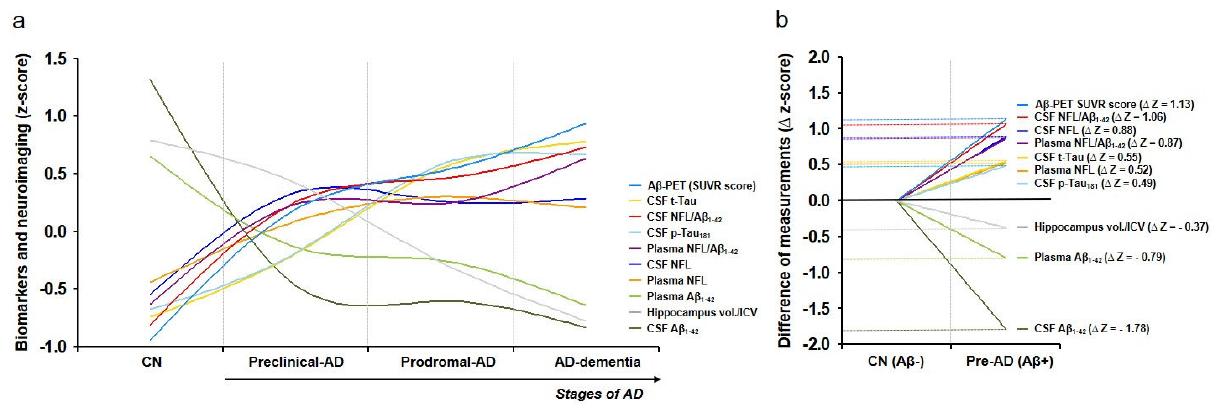
Figure 3. Dynamics of measurement. To compare biomarkers and neuroimaging data with different dynamic ranges, measurements were converted to z ‐ scores (mean values of normalized biomarker levels of each group) based on the distribution in this study cohort. The plot indicates the mean z ‐ scores for a given biomarker connected across progressively more affected diagnostic groups by a smoothing spin line using SigmaPlot 10.0 ( a ). The ∆ z ‐ score was calculated to compare the z ‐ score differences between the cognitively normal (CN A β− and preclinical AD (CN A β +) groups ( b ).